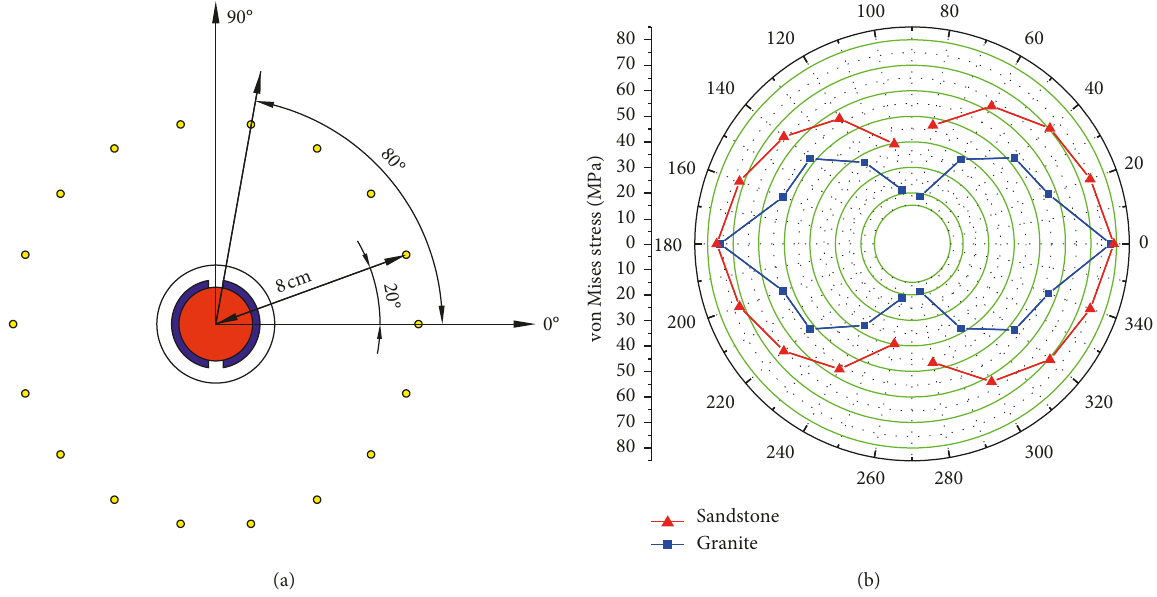
Figure 9: (a) Position of measuring points; (b) circumferential distribution of effective stress in the nonslotted direction at t � 60 μ